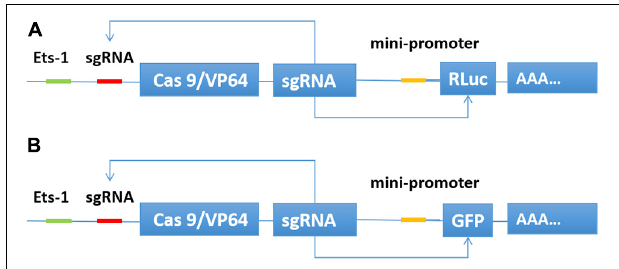
FIGURE 1 | Construction of CRISPReader sensing the Ets-1 transcription factor. When Ets-1 binds to the promoter region, weak expression of Cas9/VP64 can be initiated. After Cas9/VP64 is combined with sgRNA, it can further bind its promoter and drive its own expression. In this way, the expression level of Cas9/VP64 is continuously increased through positive feedback, and then the transcription of luciferase (A) or GFP (B) is activated.